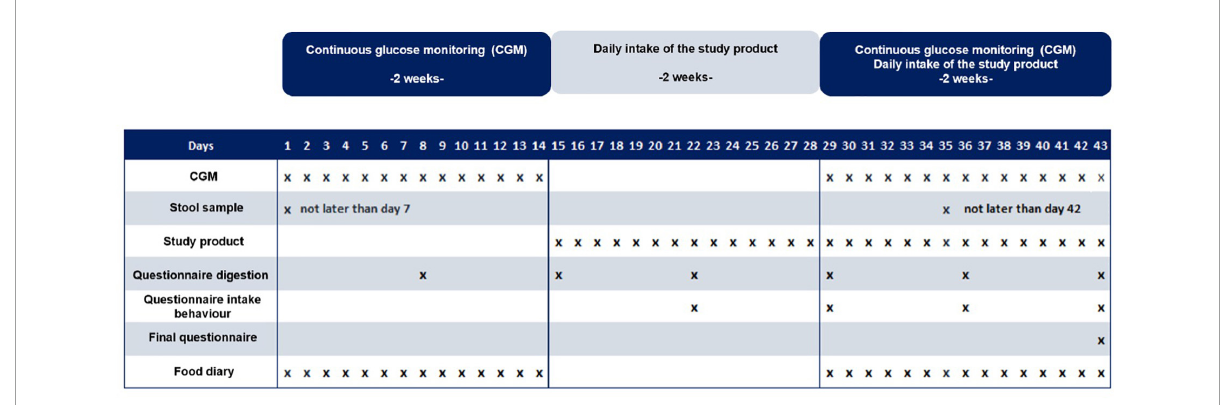
FIGURE1 Study design flow chart. The study was designed as a single-arm study.